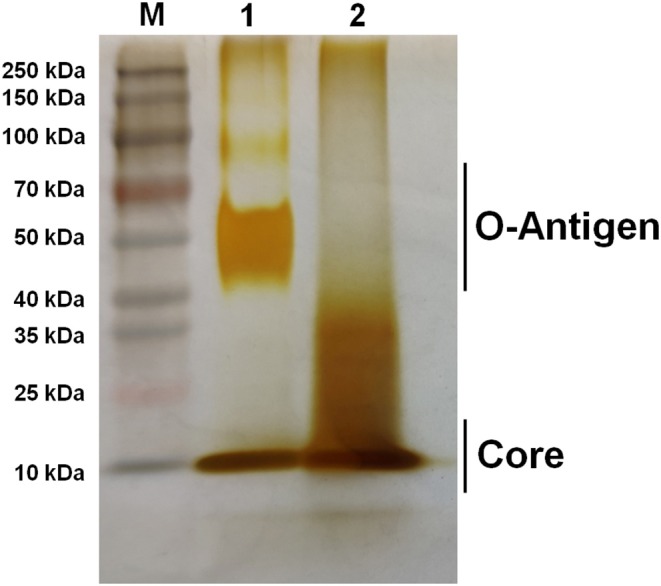
Silver staining of bacterial LPS. Lane M: Prestain page ruler (Thermo Scientific, USA); Lane 1: M1981 LPS; Lane 2: RM57 LPS.